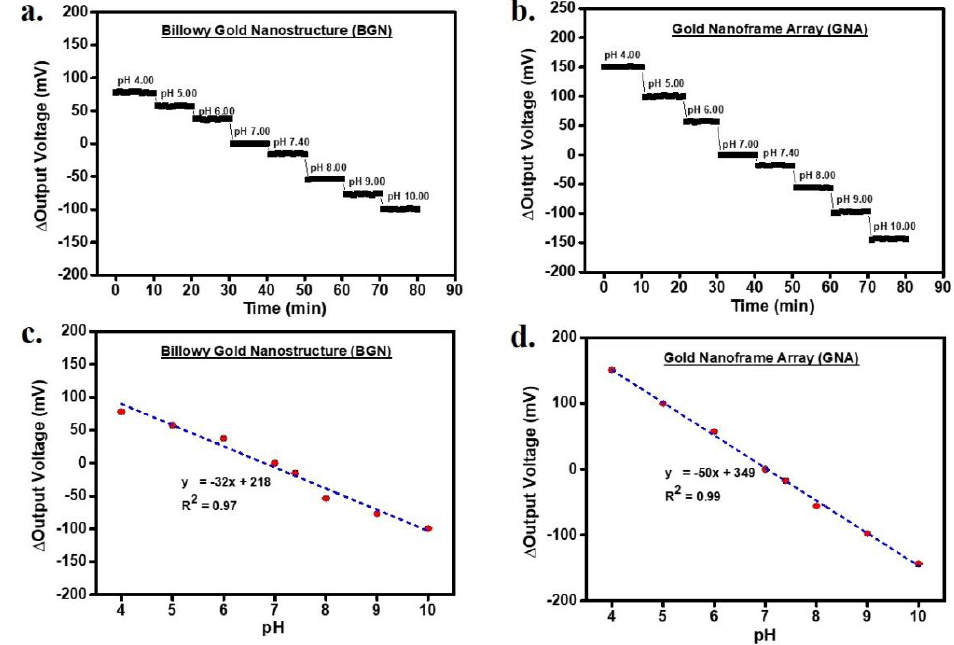
Figure 5. Real-time measurement of pH in 10 mM H 2 O 2 and the respective calibration plots per- formed by a portable CVCC circuit using the ( a ) and ( c ). billowy gold nanostructure (BGN) and formed by a portable CVCC circuit using the ( a , c ). billowy gold nanostructure (BGN) and ( b , d ). gold ( b ) and ( d ). gold nanoframe array (GNA) electrodes. nanoframe array (GNA)